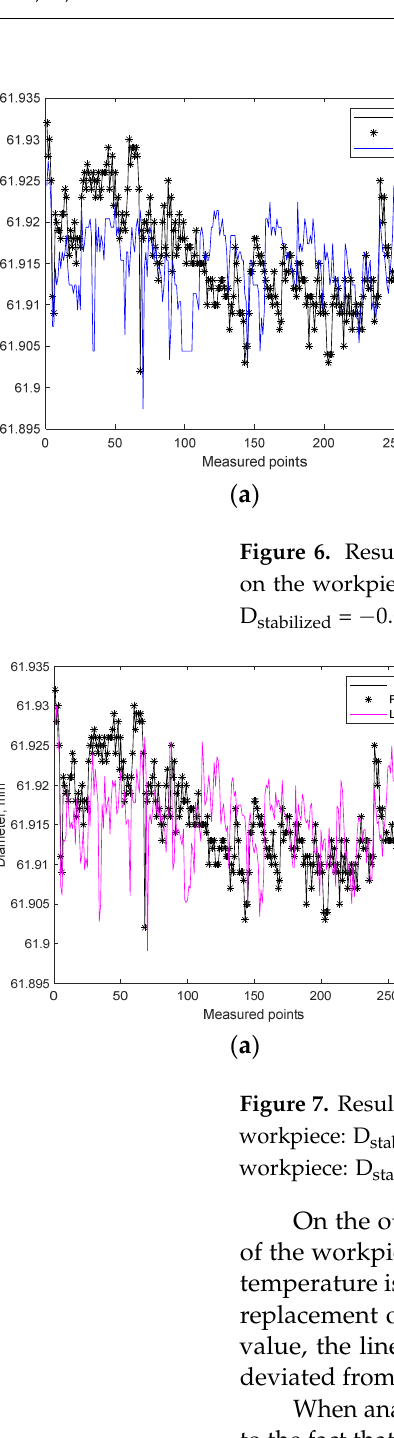
Figure 7. Results of estimation with the use of a linear model: ( a ) measurement at point A on the workpiece: D stabilized = − 0.0003 × temperature + 0.0133 + D heated ; ( b ) measurement at point B on the workpiece: D stabilized = − 0.0003 × temperature + 0.0135 + D heated .